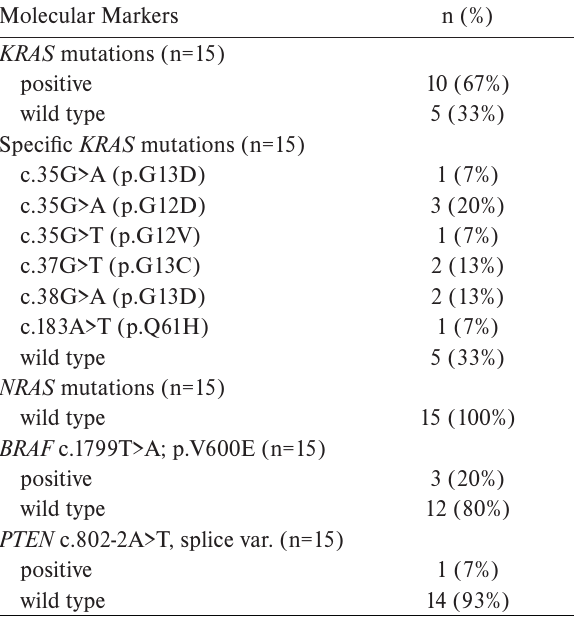
Table 2. Molecular markers: KRAS, NRAS mutation, BRAF mutation and PTEN mutation in selected metastatic colon cancer